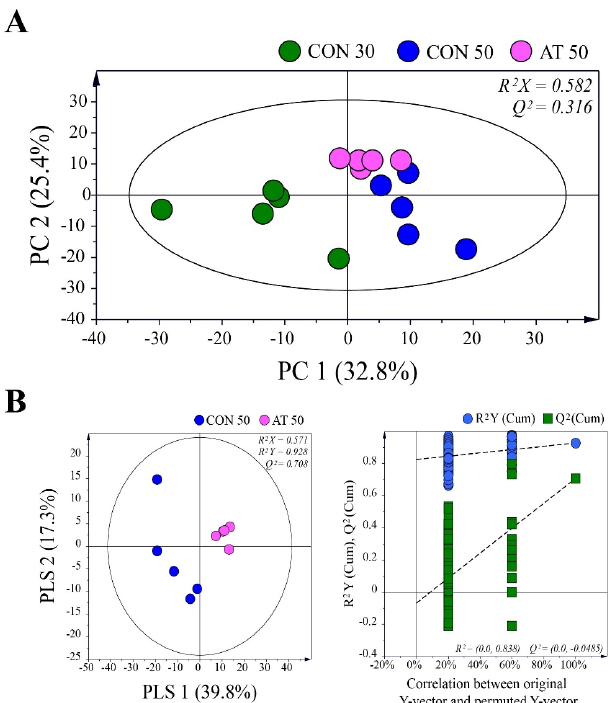
Figure 3. ( A ) Principal component analysis (PCA) score plots derived from gas chromatography-mass spectrometry (GC-MS) data for control groups (CON30 and CON50) and the ampicillin-treated group (AT50) during kimchi fermentation. ( B ) Partial least squares-discriminant analysis (PLS-DA) score plot between the CON50 and AT50 groups after 50 days of fermentation validated by a permutation test. Table 1. Significantly different metabolites between the control and ampicillin-treated group after 50 days of kimchi fermentation.